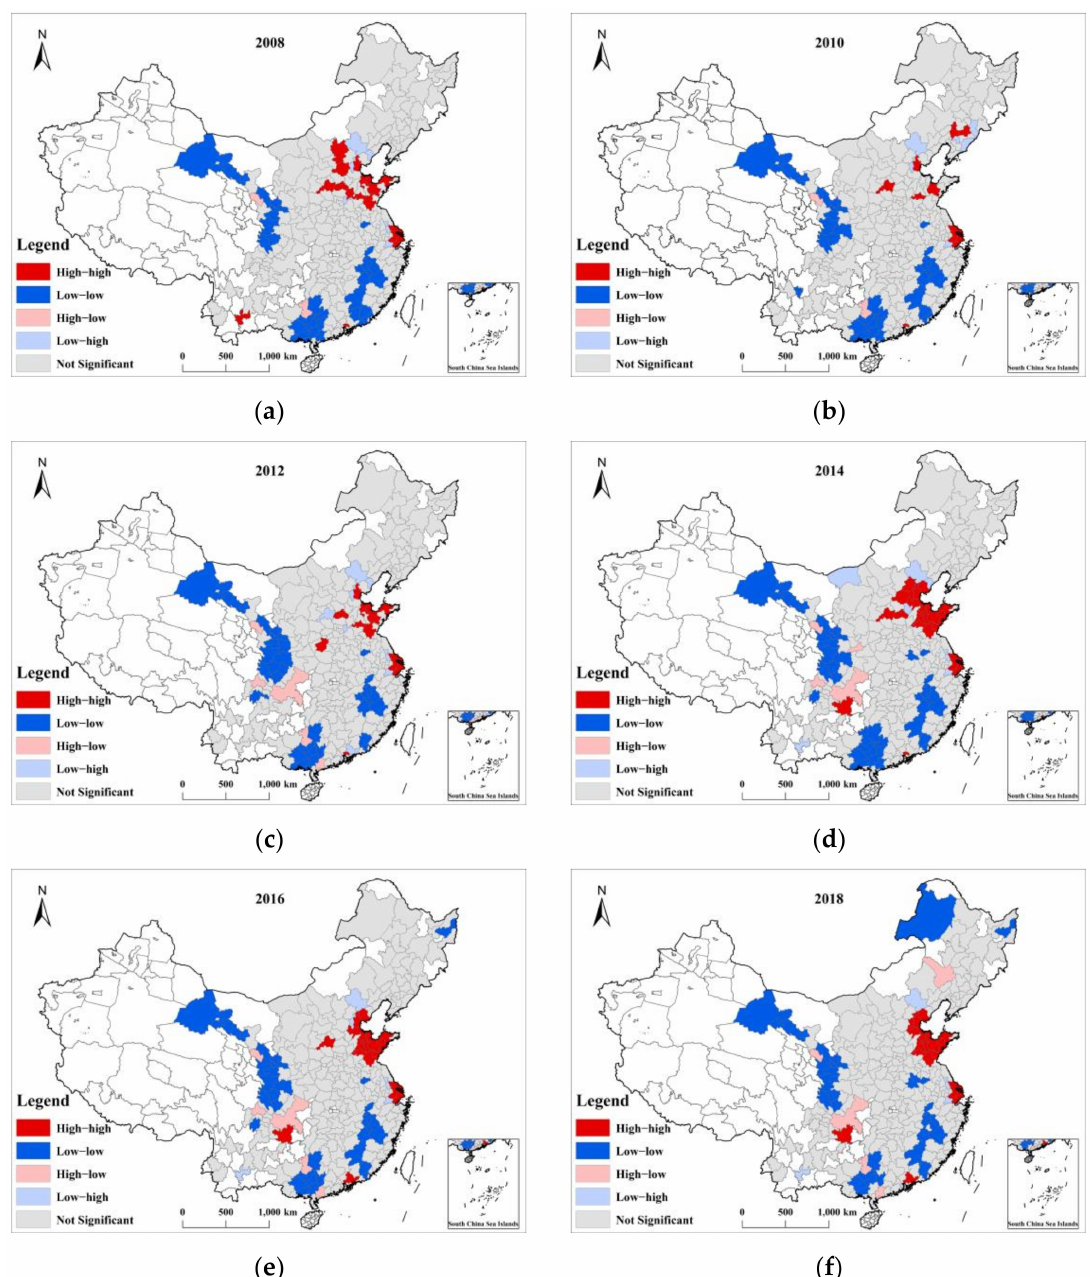
Figure 3. The local spatial autocorrelation of UCEs in China between 2008 and 2018. ( a ) 2008; ( b ) 2010; ( c ) 2012; ( d ) 2014; ( e ) 2016; ( f ) 2018. Note: This figure shows only the results of even years, and the results of odd years can be seen in Supplementary